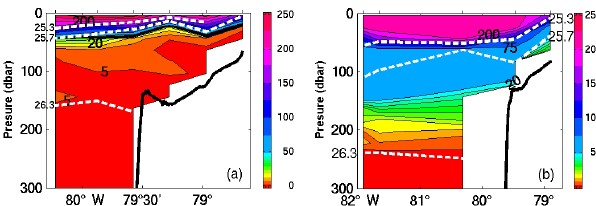
Figure 9. Oxygen section (color; inµmolkg − 1 ; same color scale in both frames) at ∼ 9 ◦ S off the Peruvian shelf for Decem- ber 2012 (a) and October 2015 (b) . Three selected isopycnals are included as white dashed lines. Please note that the section in Octo- ber 2015 reaches further west than in December 2012.